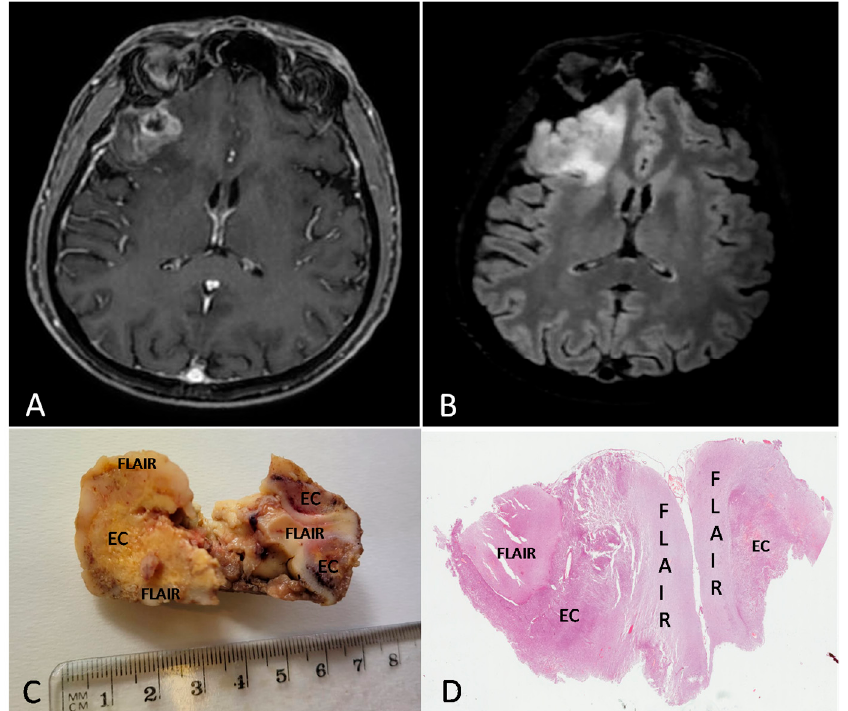
Figure 2. Preoperative MRI from a 57-year-old man. ( A ) Axial section of a T1w sequence with gadolinium showing a left frontal tumor with necrotic core and ring enhancement. ( B ) FLAIR sequence showing a hyperintensity beyond the EC. ( C , D ) Gross image ( C ) and histologic low magnification ( D ) showing both EC and FLAIR region from the excised mass (( D ) H&E; original magnification 25 ×